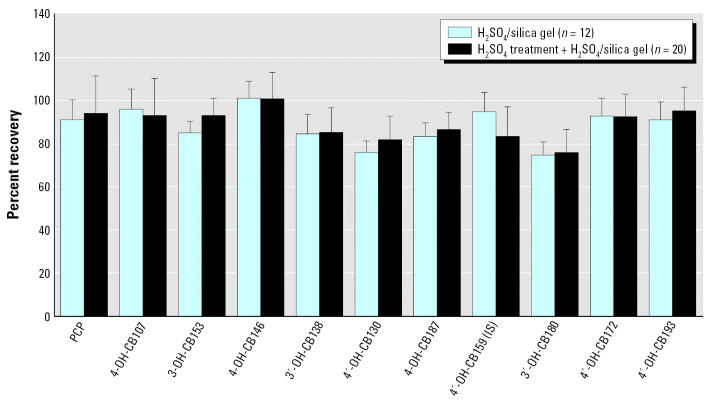
Percent recovery of OH-PCBs from spiked control serum samples applying two different cleanup procedures. IS, internal standard.